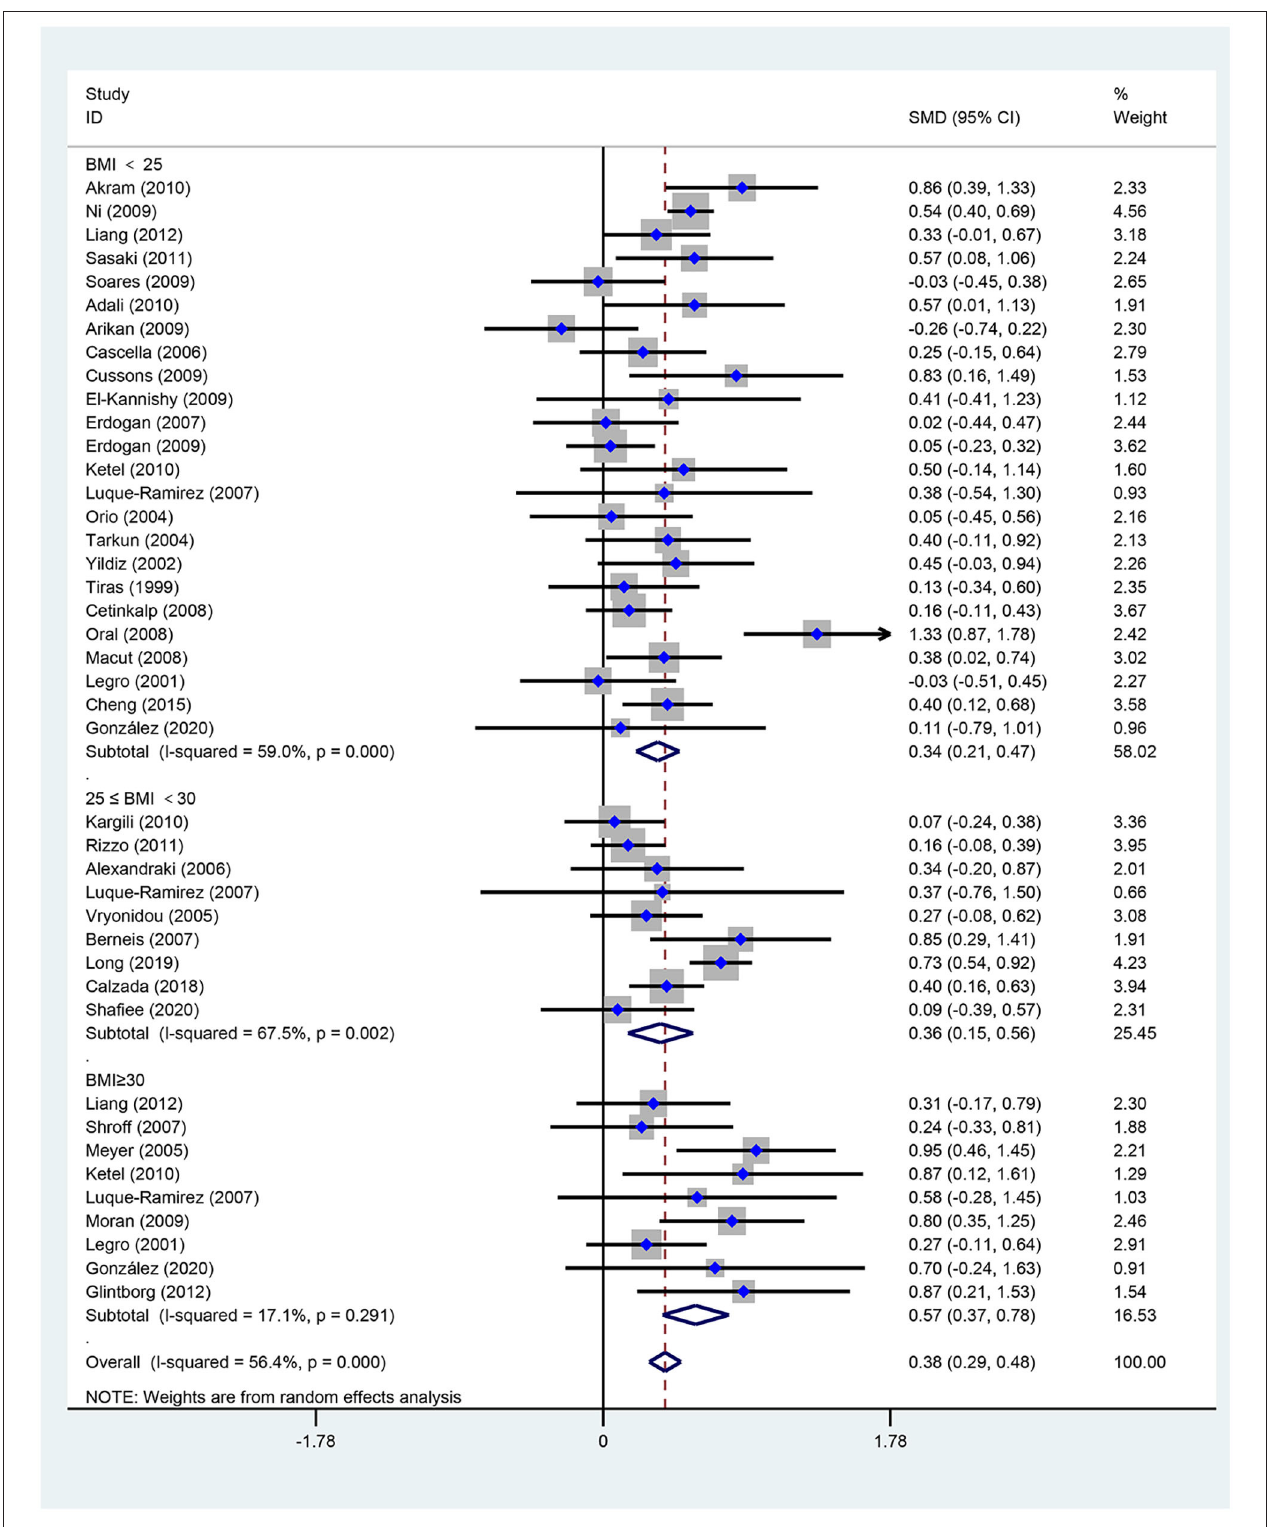
FIGURE 3 | Forest plot for comparison of triglycerides in polycystic ovary syndrome vs. control subjects. Studies are classified by different body mass index (BMI) categories (BMI < 25 kg/m 2 , BMI ≥ 30 kg/m 2 , and BMI 25–30 kg/m 2 ).